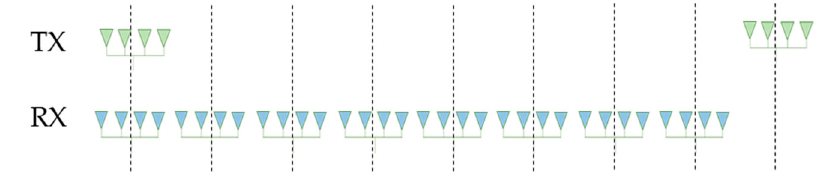
Figure 16. Final beampatterns by non-redundant MIMO steered to 0° ( up ) and 5° ( down ). Finally, if two transmitters and eight receivers with about 18 wavelengths are config- ured as shown in Figure 17, the final aperture becomes a uniform array of 36 wavelengths.